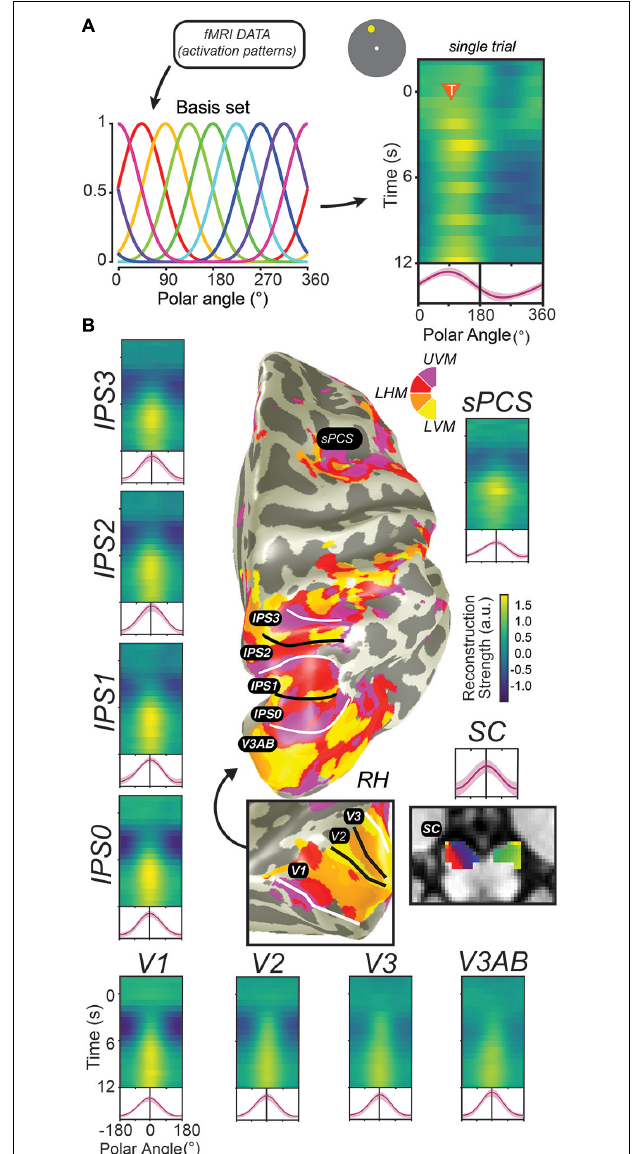
FIGURE 4 | Decoding methods reveal stimulus-selective persistent activity across cortical and subcortical regions in the human brain. (A) Recent studies have employed “IEMs,” which model the activation of each voxel as a weighted combination of neural information channels (Brouwer and Heeger, 2009; Ester et al., 2013; Sprague et al., 2018). Applying this method results in reconstructed channel response profiles for each timepoint of each trial. When a measured activation pattern contains a representation of the remembered information, these reconstructed channel response profiles peak at the corresponding feature value. Right: single example trial illustrating a persistent representation of the remembered location on that trial based on activation patterns in V3AB (orange triangle indicates onset of delay period and remembered feature value). (B) When applied to activation patterns in retinotopic cortical regions and the superior colliculus while participants perform a memory-guided saccade task, representations of remembered positions are universally recovered. For each ROI, we show a timecourse of reconstructed representations (each row is a single timepoint; average of reconstructions for all experimental trials aligned to the remembered location),